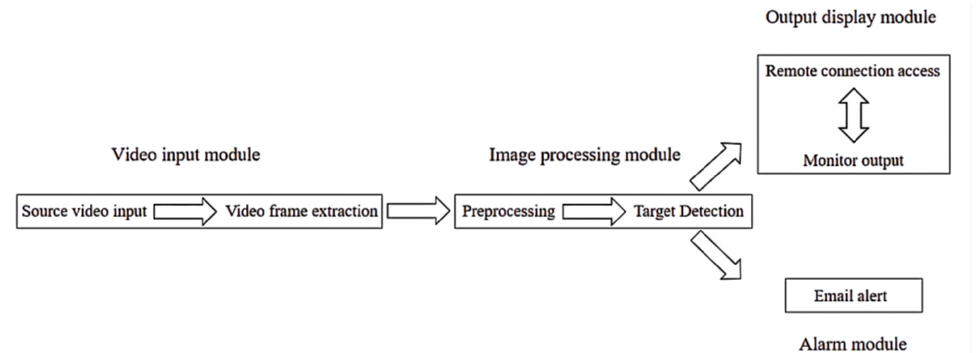
Figure 1. System overall design block diagram.